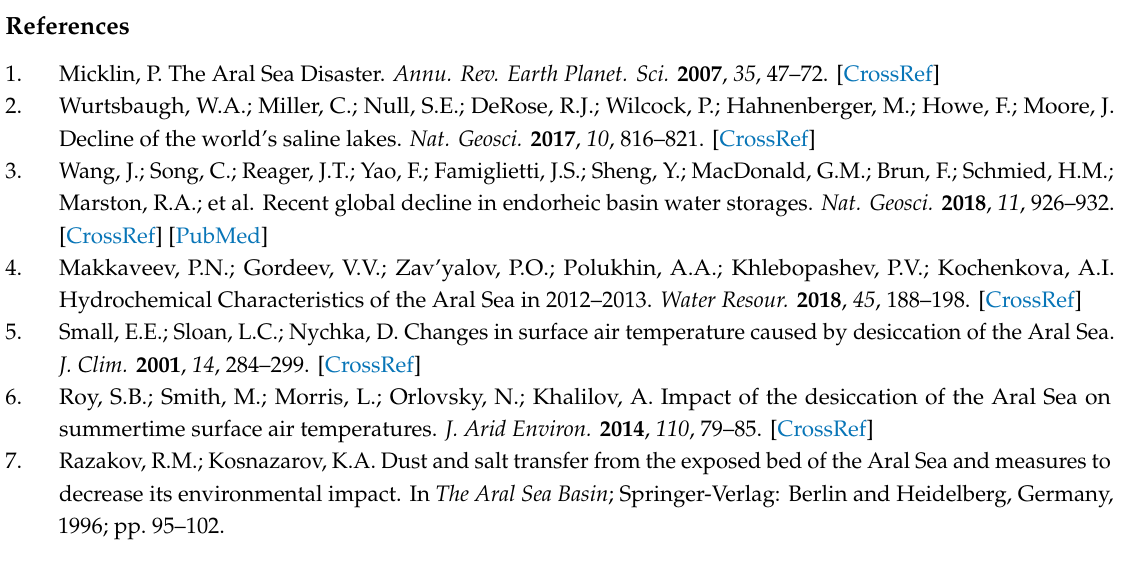
Table S1: The detailed information for sampling